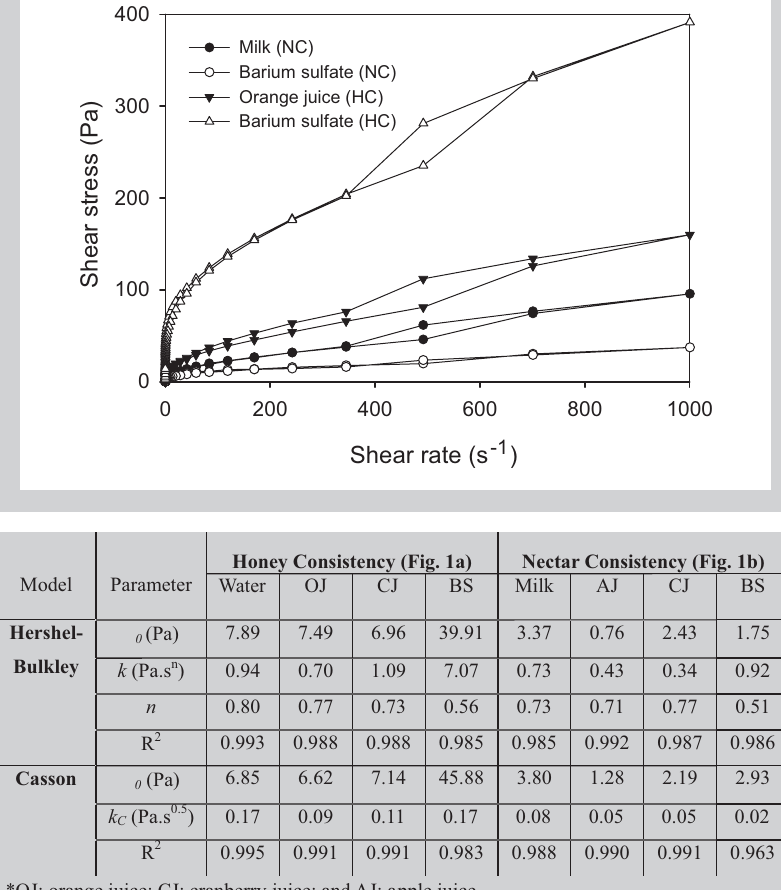
Table 2: Hershel-Bulkley and Casson model parameters and R 2 values for different rheolog- ical models to describing vis- cosity and flow curves of videofluoroscopic barium sulfate (BS) suspensions and pre-thickened beverages* used in the diagnosis and treatment of dysphagic patients. Figure 2: Flow curves of nectar consis- tency (NC) and honey con- sistency (HC) samples tested applying increasing and decreasing shear rates to evaluate